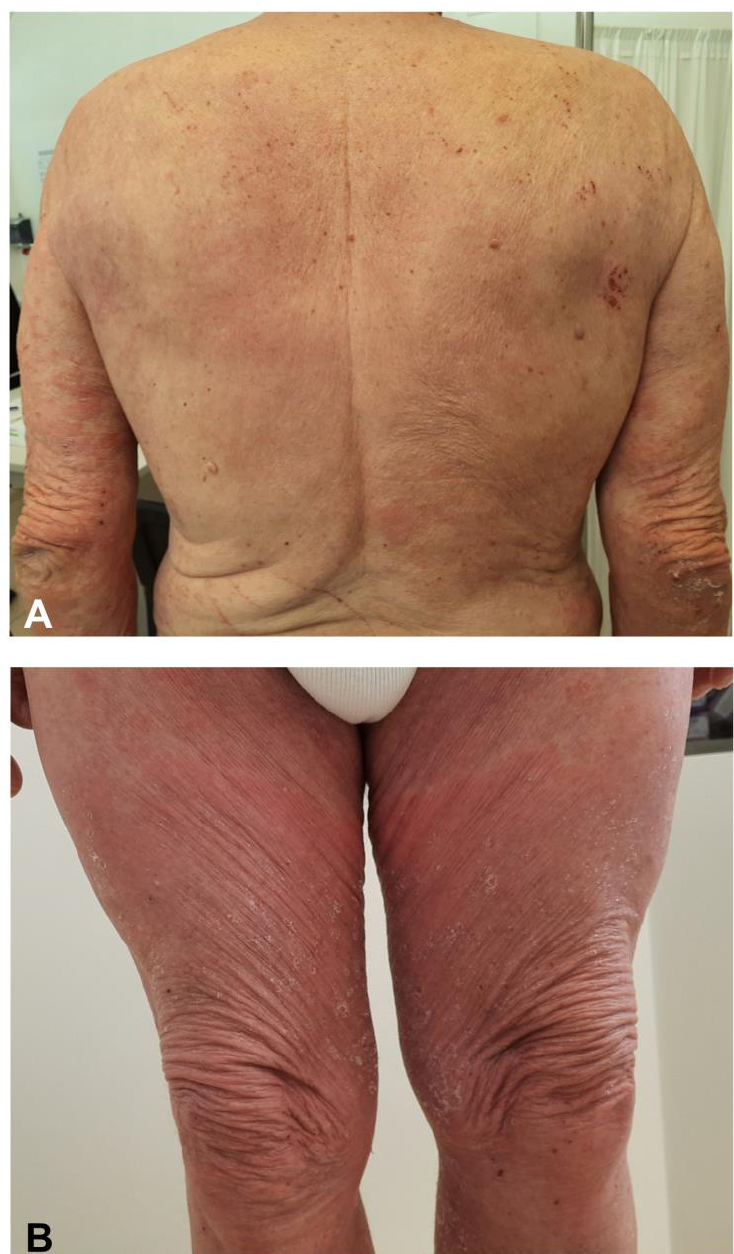
Figure 5. Diffuse bilateral eczematous lesions with overlying excoriation of the back, arms, and legs on a patient without a history of atopic dermatitis following the AZD1222 vaccine (71-year-old man) ( A , B ).